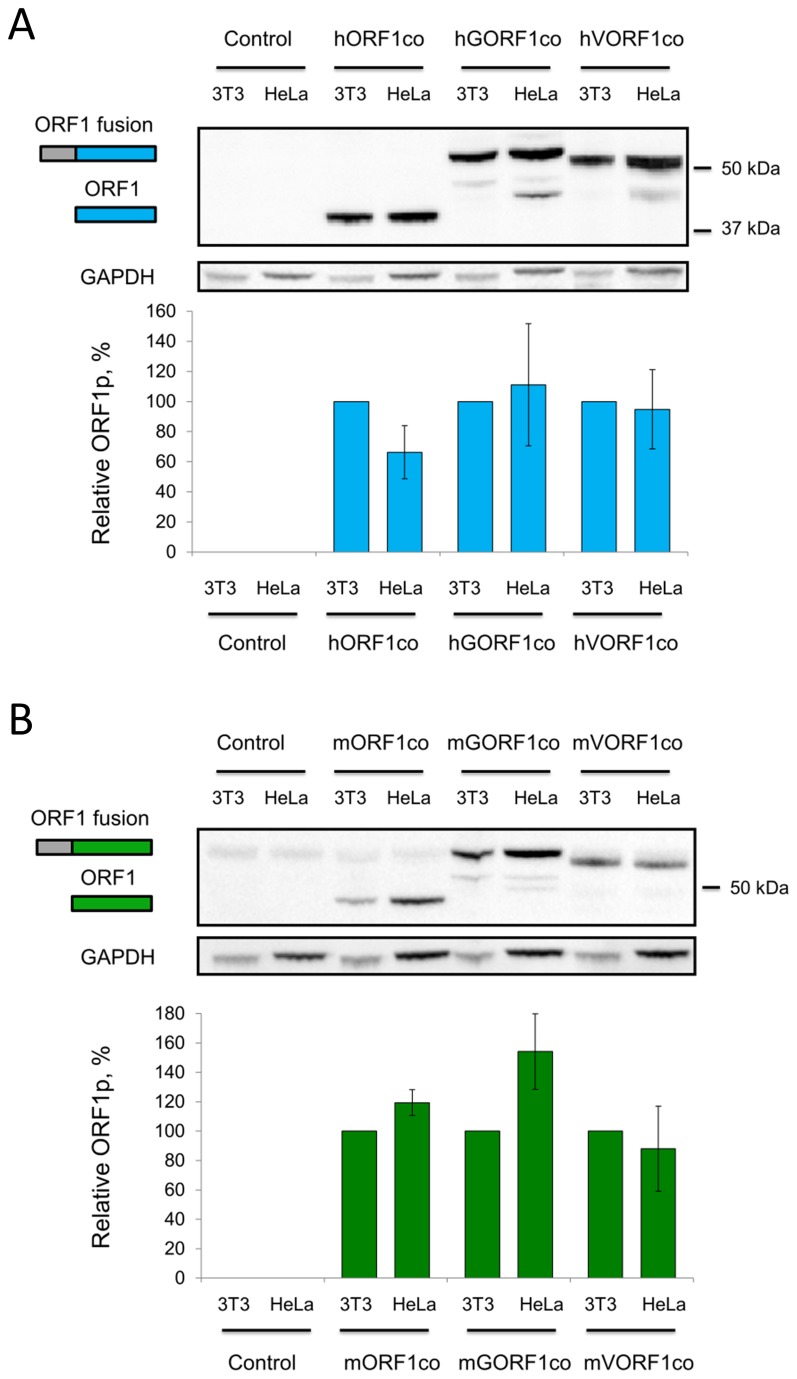
Analysis of M2H ORF1 fusion protein expression in human and mouse cells.
A. (top) Western blot analysis of codon-optimized human ORF1 (hORF1co, 40 kDa, blue rectangle labeled as ORF1) and human ORF1co N-terminally fused to GAL4 or VP16, (hGORF1co, 57 kDa, and hVORF1co, 49 kDa, blue and grey rectangles labeled as ORF1 fusion) transiently transfected in HeLa or NIH-3T3 cells. Human ORF1 protein was detected with custom-made human-specific ORF1 polyclonal antibodies. GAPDH is used as a loading control. 37 and 50 kDa are molecular markers. Control lanes indicate cells transfected with an empty vector. (bottom) Quantitation of western blot results. Signals obtained for hORF1p and its fusions were normalized to their respective GAPDH loading controls and expressed as a percentage of the relative signal detected for each protein in NIH-3T3 cells. B. (top) Western blot analysis of codon-optimized mouse ORF1 (mORF1co, 47 kDa, T7-Myc-His tag, green rectangle labeled as ORF1) and mouse ORF1co N-terminally fused to GAL4 and VP16 (mGORF1co, 60 kDa, and mVORF1co, 52 kDa, green and grey rectangles labeled as ORF1 fusion) transiently expressed in HeLa or NIH-3T3 cells. 50 kDa is a molecular marker (bottom) Quantitation was performed as described in A.